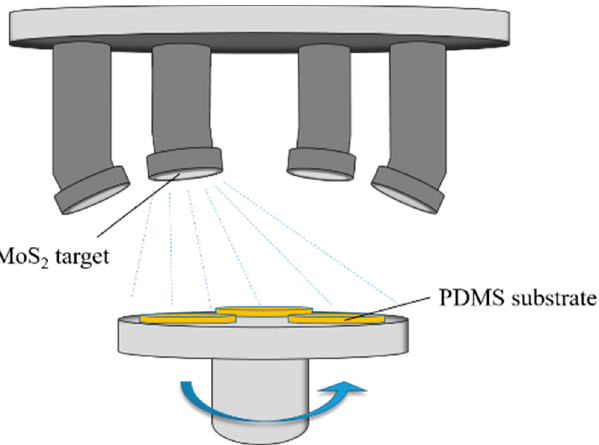
Figure 3. Schematic diagram of the molybdenum disulfide (MoS 2 ) thin film sputtering deposition system.